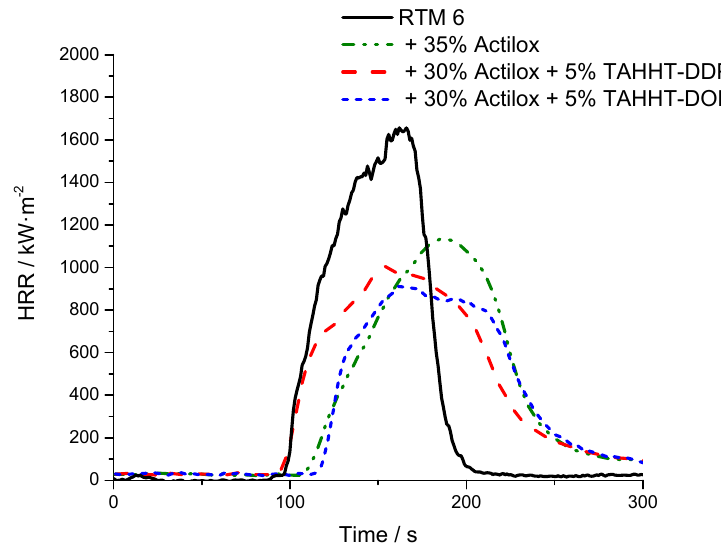
Figure 16. HRR of different specimen with and without Actilox B30 at 35 kW·m − 2 .